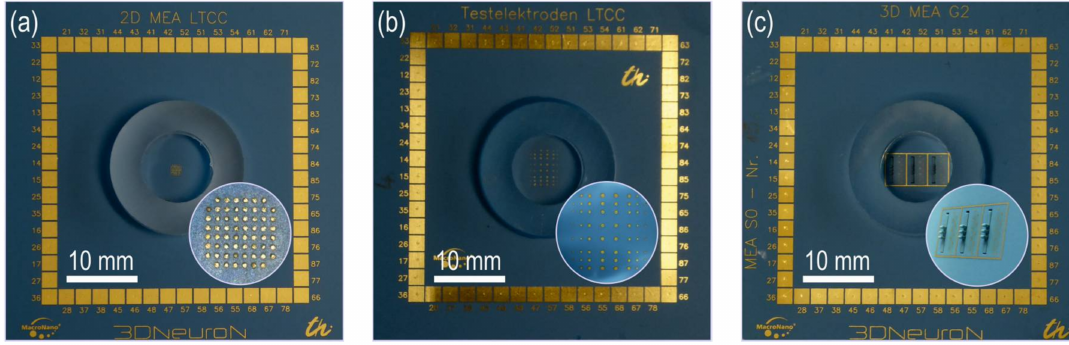
Figure 2. Test chip types ( a ) 2D test chip Type A; ( b ) 2D test chip Type B; ( c ) 3D test chip Type C.